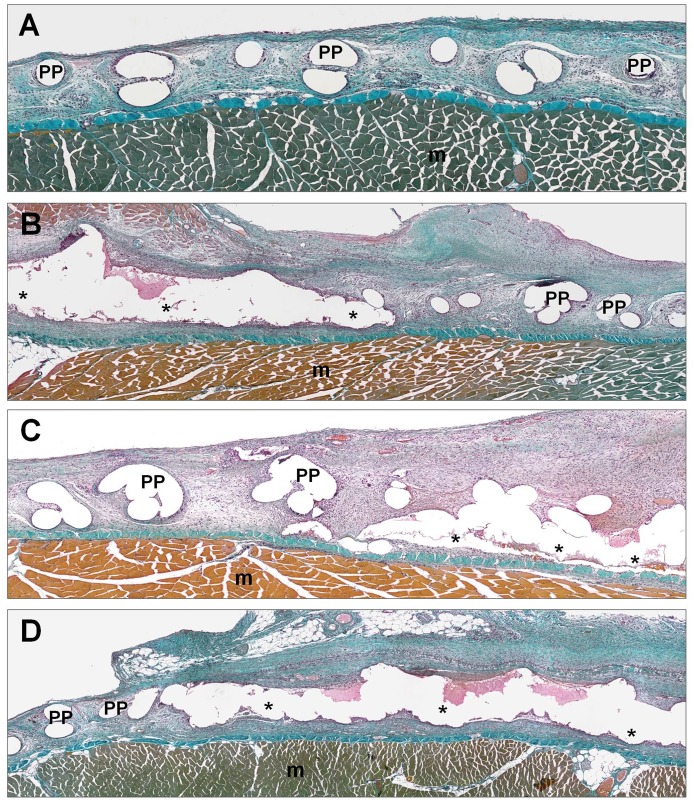
Morphological analysis.Panoramic light microscopy images of tissue integration of the reticular PP mesh (Surgipro) fixed with the different CAs (Glubran, Ifabond and OCA) and sutures (control group) 14 days after implantation. Masson’s trichrome staining (100x). (A) Image of PP mesh fixed with sutures in the control group (100x). (B) Image of PP mesh fixed with Glubran (100x). (C) Image of the PP mesh fixed with Ifabond (100x). (D) Image of PP mesh fixed with OCA (100x). (*: Tissue Adhesive; PP: polypropylene filaments; m: muscle).